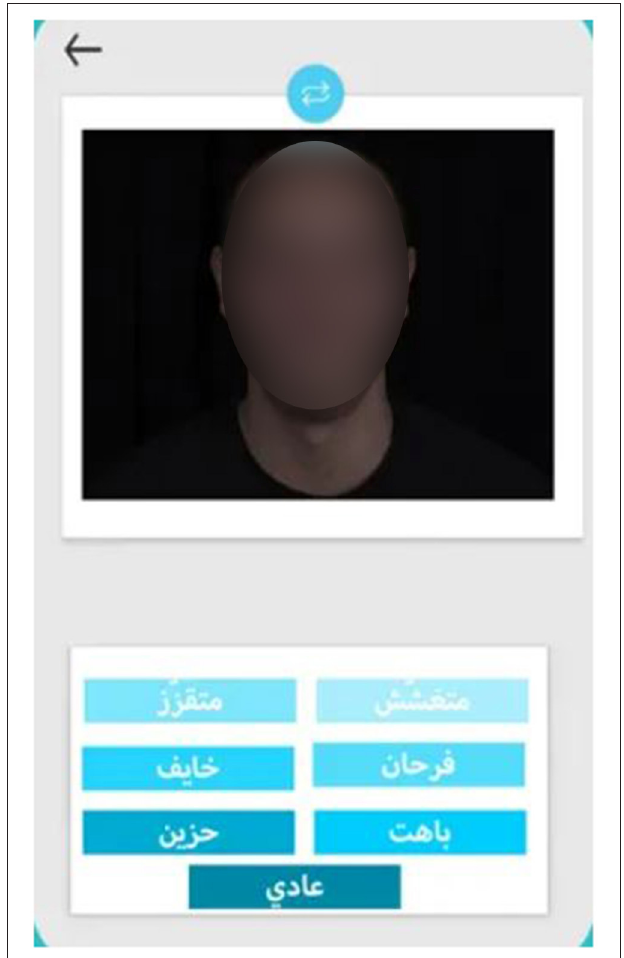
FIGURE 1 | Interface of the REF